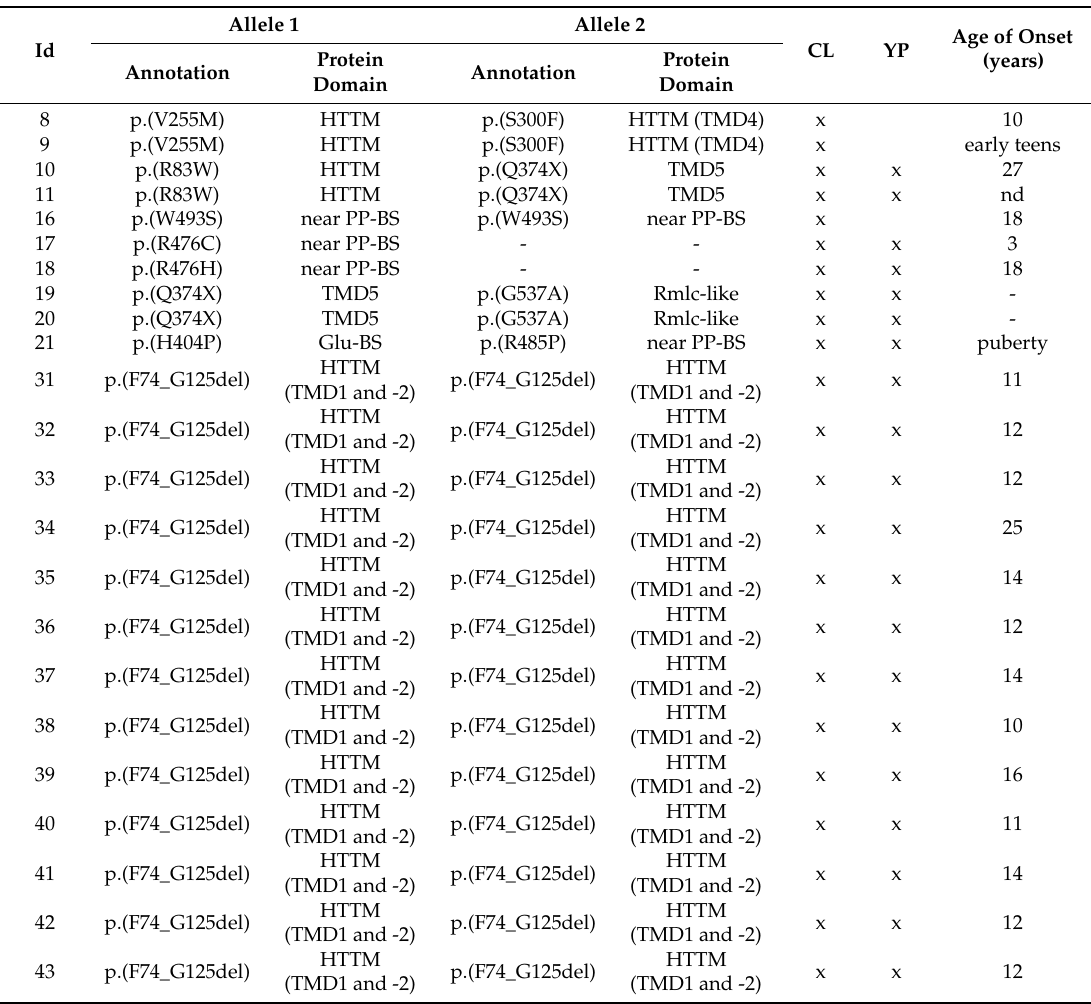
Table 5. GGCX-related skin manifestations in analyzed patient cohort. This table gives an overview of all patients in the analyzed cohort with skin features. For each patient, the GGCX mutations on both alleles and the affected protein domain are stated (protein annotation). Further, a brief overview of the skin symptoms is